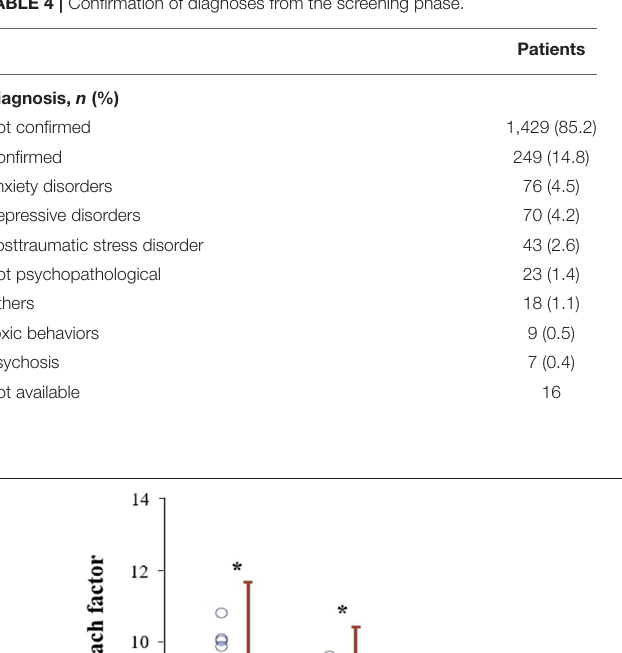
TABLE 4 | Confirmation of diagnoses from the screening phase.